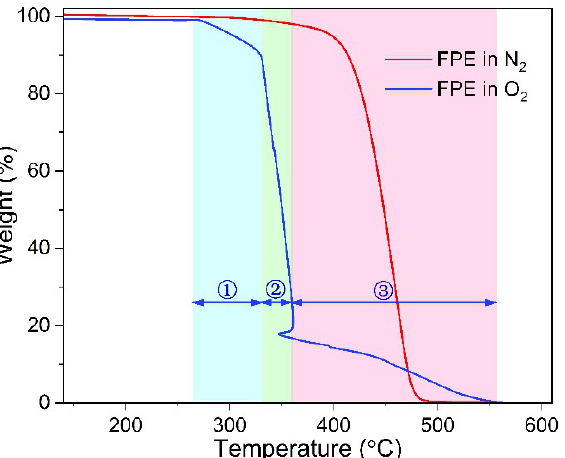
Figure 8. Comparison of TGA curves of FPE material in N 2 and O 2 atmospheres.